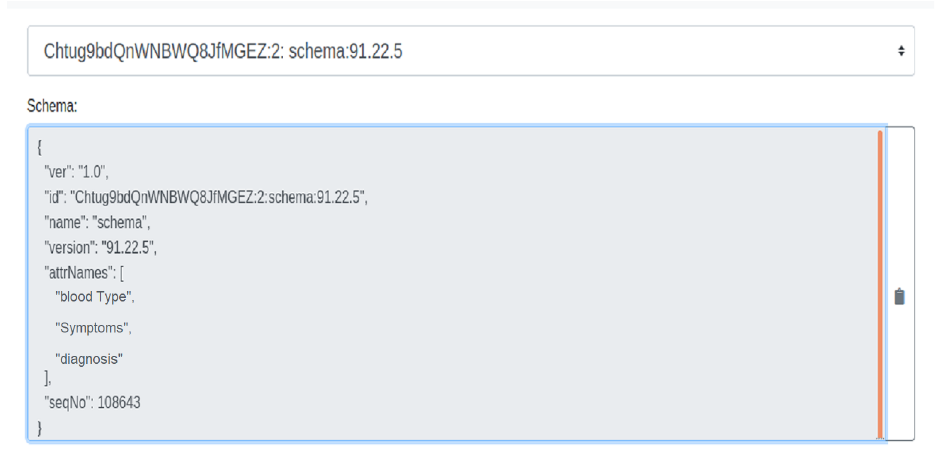
Figure 11. Alice provides Bob with the DID and list of his